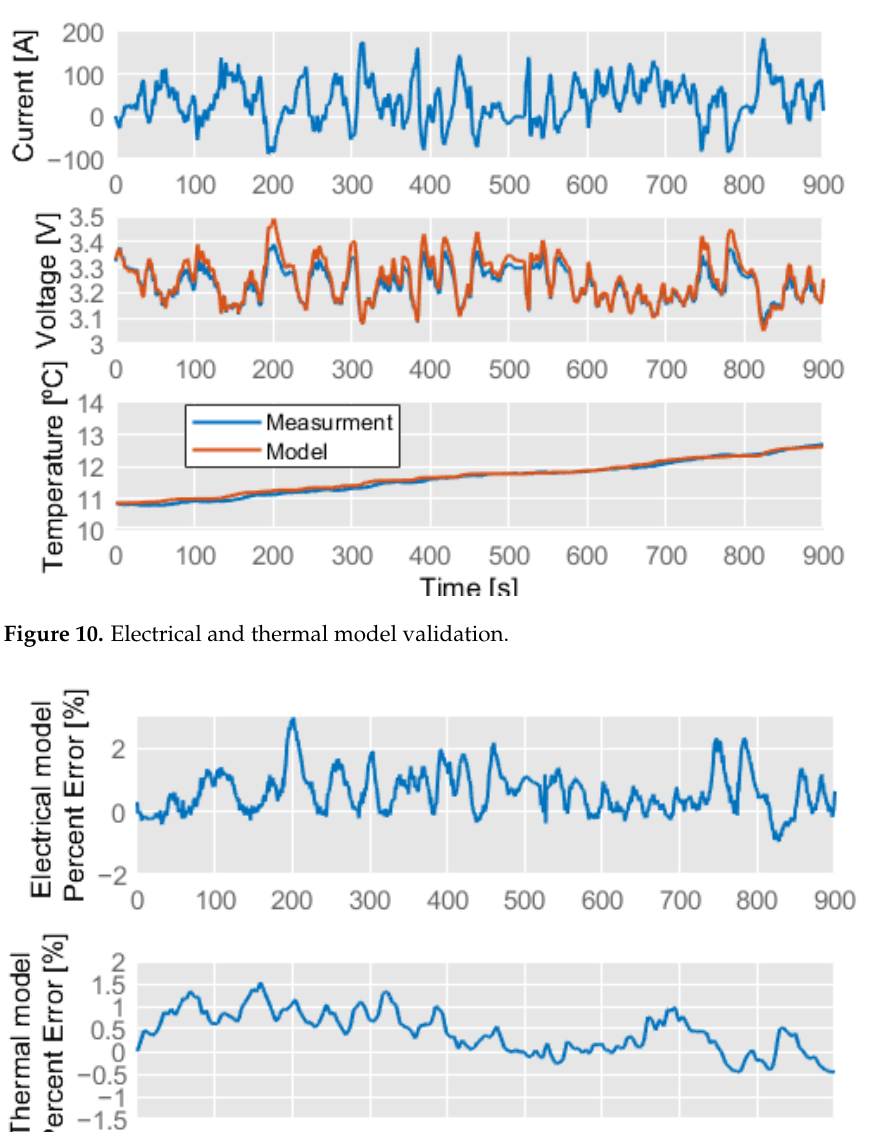
Figure 11. Electrical and thermal model errors.